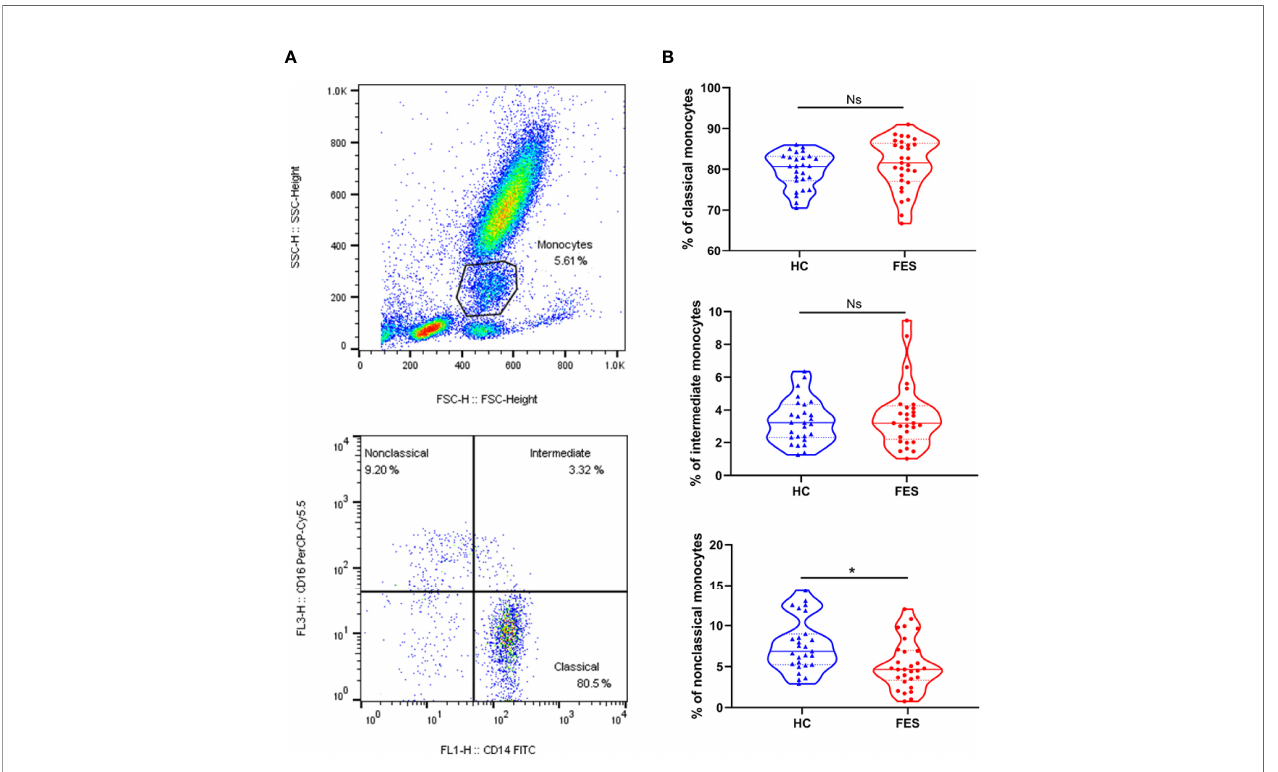
FIGURE 2 | Nonclassical monocytes are decreased in the peripheral blood of FES patients. Whole blood sample was stained with monocytic markers FITC-labeled mouse anti-human CD14 and PerCP-Cy ™ 5.5-labeled mouse anti-human CD16 and measured by fl ow cytometry. (A) Dotplots show gating strategy. Monocytes were fi rst selected based on size (forward scatter height) and granularity (side scatter height), and then monocytic subsets were de fi ned according to surface expressions of CD16 and CD14. The CD14++CD16- classical monocytes, CD14++CD16+ intermediate monocytes, and CD14+CD16++ nonclassical monocytes were quantitated, respectively. (B) Violin plots show the blood monocytic subsets in HCs and FES patients. Solid and dotted lines represent the median and upper/ lower quartile values, respectively. Ns, Not signi fi cant. * FDR < 0.05. See also Supplementary Table 5